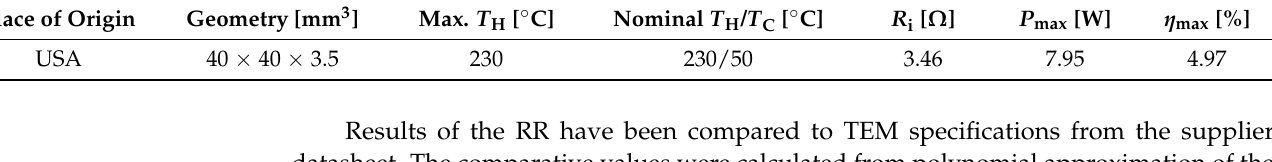
Table 1. Information on the module type selected for RR tests according to manufacturer specifications. The geometry data refer to the cross-section area, which is available for thermal coupling. The nominal hot and cold side temperatures T H and T C give the testing conditions of the specified module